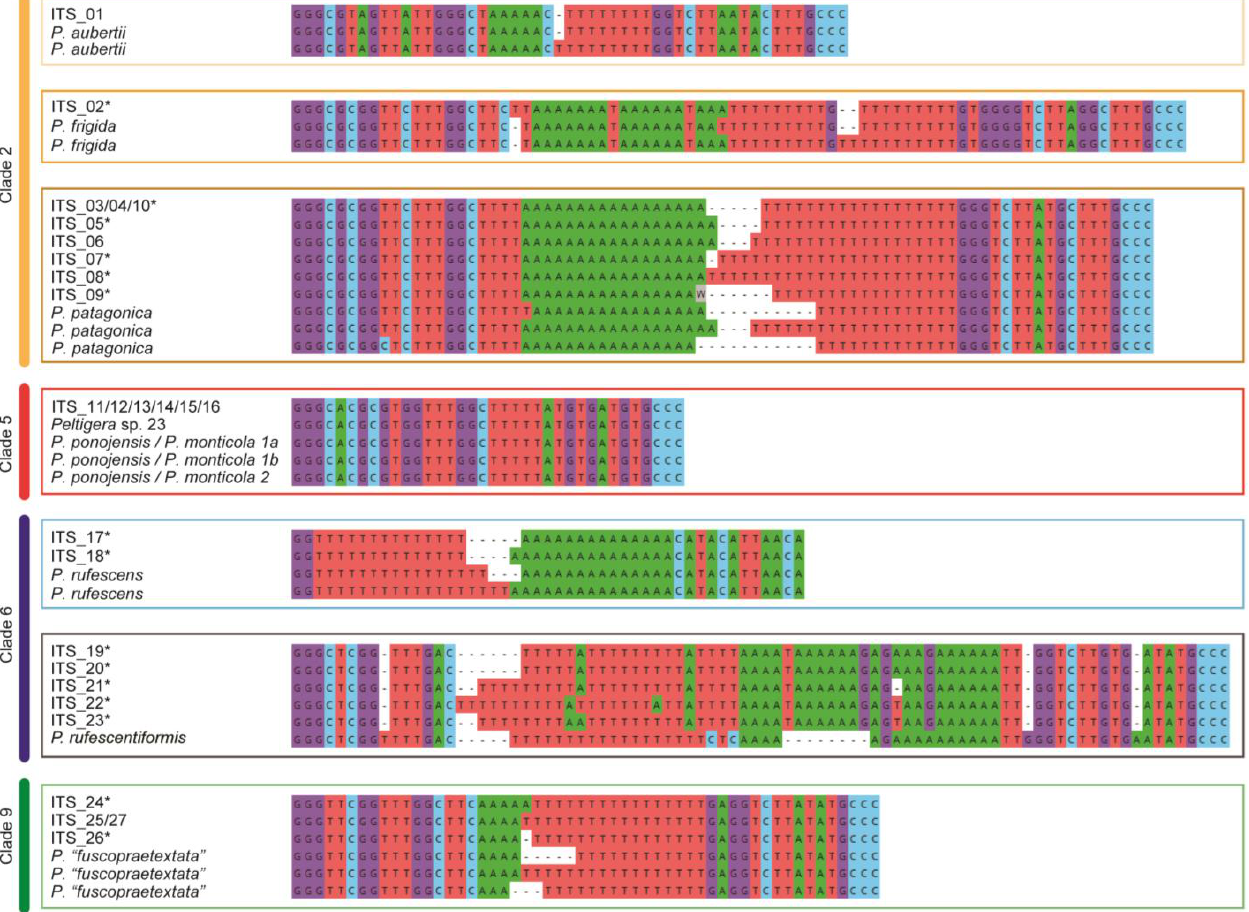
Figure 3. ITS1-HR sequences of the samples from this study and the closest reference sequences grouped by Peltigera clades, according to Magain et al. [13]. Asterisks indicate novel sequences of ITS1-HR.